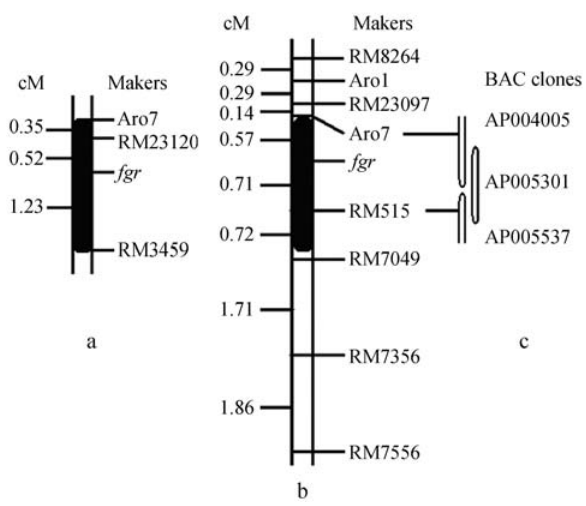
Figure 1 - Location of the fragrance gene in chromosome 8. (a) Linkage map of the Ch-29B/R2 F 2 . (b) Linkage map of the Ch-29B/Le F 2 . (c) The